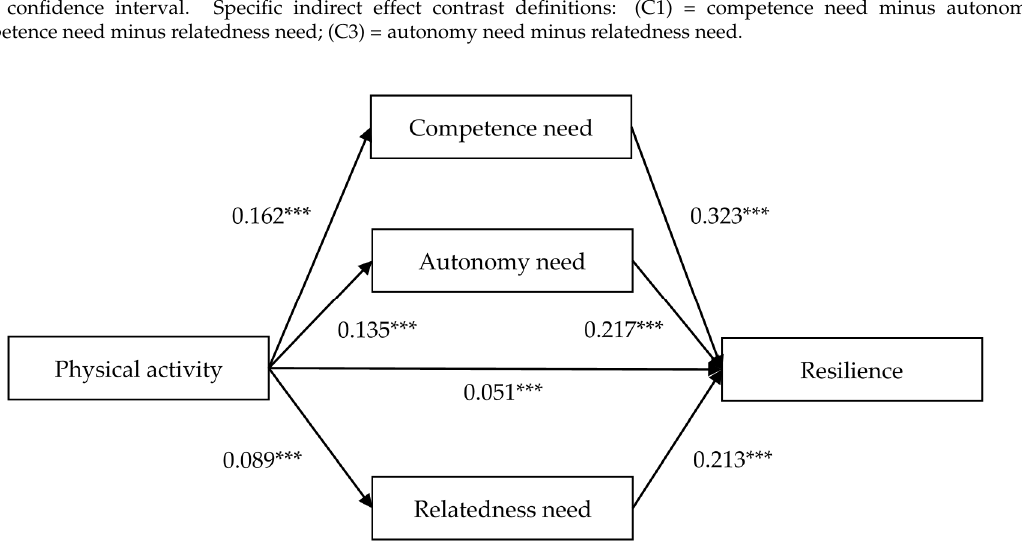
Figure 2. Mediation effect analysis of basic psychological needs satisfaction between physical activity and resilience; *** p < 0.001. Demographic variables were controlled as covariances.